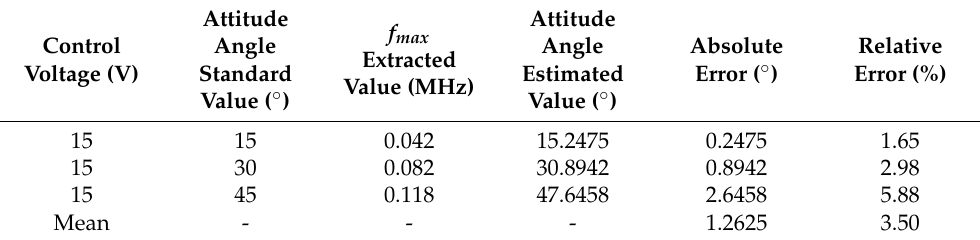
Figure 11. TF diagram of experimental results. ( a ) Attitude angle = 15°. ( b ) Attitude angle = 30°. ( c ) Attitude angle = 45°. Table 5. Cube target attitude angle estimation results.